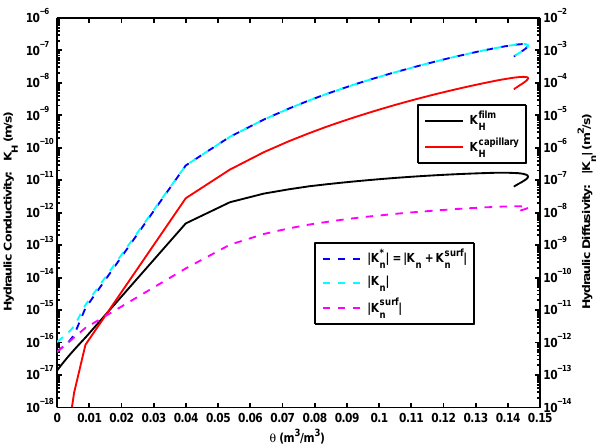
Figure 10. Comparison of measured (symbols) and modeled (lines) soil temperature during the Palousse B Wet heating experiment. The solid lines are for a model simulation that does not include the dy- namic residual soil moisture, θ r ; the dotted lines correspond to the simulation that includes θ r . included05 symbols = data solid lines: θ r not included dotted lines: θ r